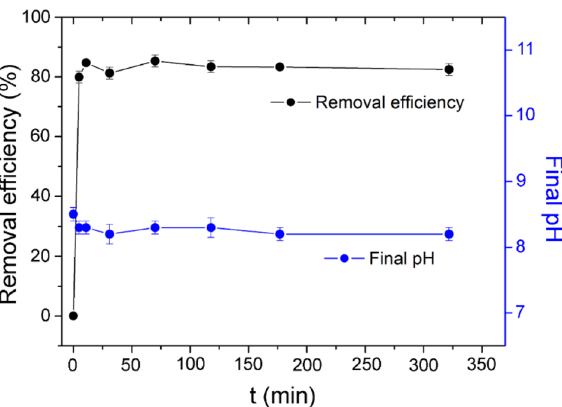
Figure 10. The effects of contact time on the efficiency of Sr removal from SW and final pH values.